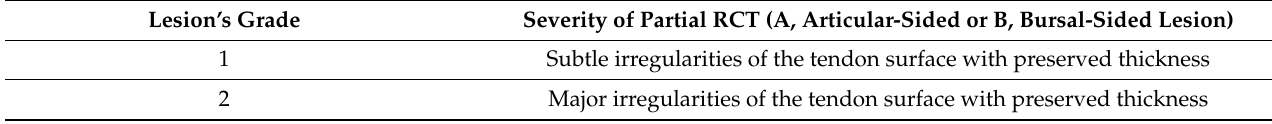
Table 2. Adaptation to US of arthroscopic Snyder’s classification of